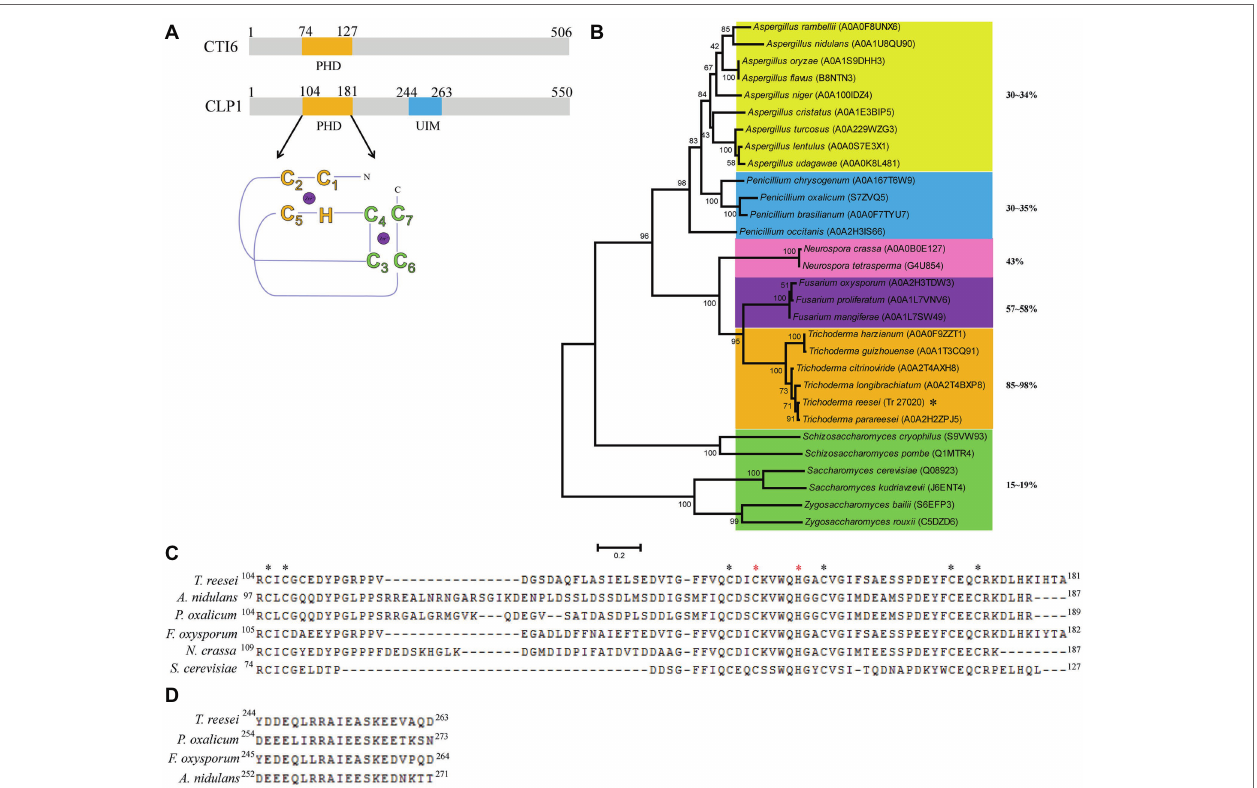
FIGURE 1 | Sequence and phylogenetic analysis of CLP1 and its homologs. (A) Schematic diagram of CLP1 containing a conserved C4HC3 PHD finger and a UIM. The yeast CTI6 diagram is also shown. (B) Phylogenetic analysis of CLP1 and its homologs from Trichoderma , Penicillium , Fusarium , Neurospora , and Aspergillus species. The phylogenetic tree was generated with MEGA6. Numbers on the tree branches represent the bootstrap support calculated per 1,000 bootstrap replicates. The sequence identity between CLP1 and its homologs is indicated. (C) Sequence alignment of the PHD in CLP1 and its homologs. The conserved amino acid of C 4 HC 3 motif is indicated by asterisks and the two residues (C145 and H150) to be mutagenized in this study are indicated with red asterisks. (D) Sequence alignment of the UIMs in CLP1 and its